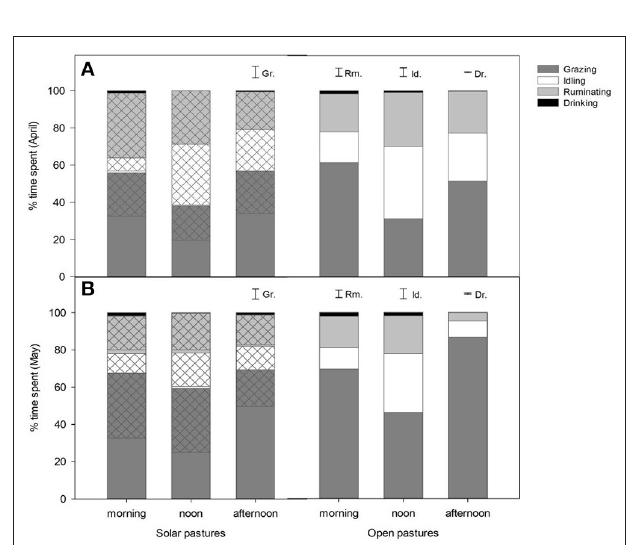
Lambs grazing solar pastures spent 96.1 and 96.5% of their idling time in shade directly under solar panels in April and May, respectively ( P = 0.95) ( Figures 7A,B ). They also did their ruminating activities predominantly under the shade of the panels with an average 99.8% and 92.7% of their time in April and May, respectively. No period or time of the day effects were observed for the ruminating or idling time that was spent under shade (All P > 0.05). However, there was a tendency for period time of the day interaction for grazing time spent under shade ( P = 0.09). On average, lambs only spent 43.5% of their grazing activities under solar panels, with no obvious time of the day difference in April. The grazing time that was spent under